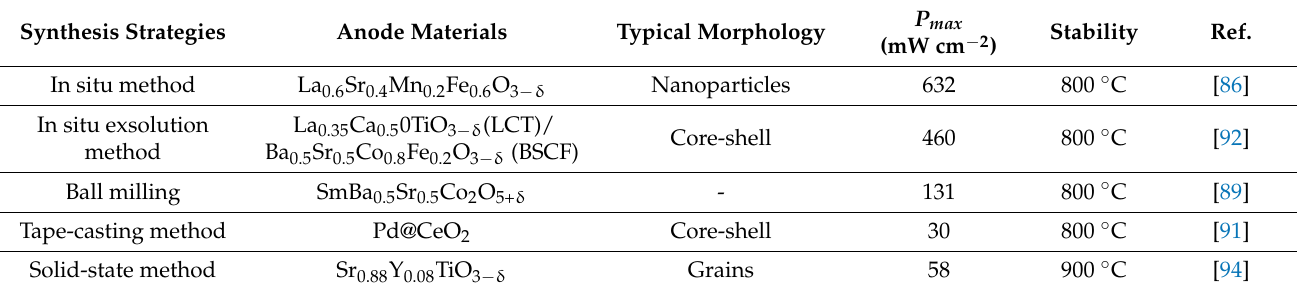
Table 3. SOFC performance of various perovskite-based anode